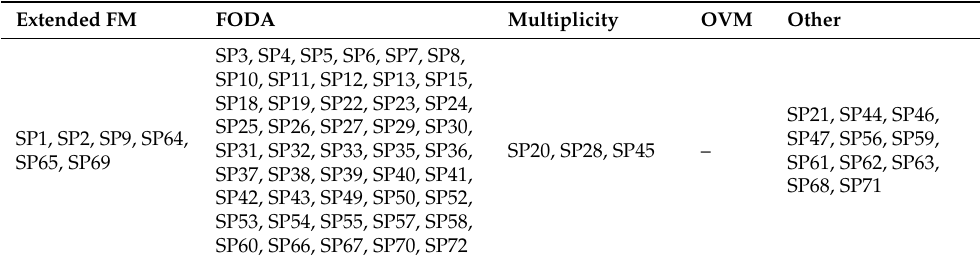
Table 14. Selected papers and FMs used for the